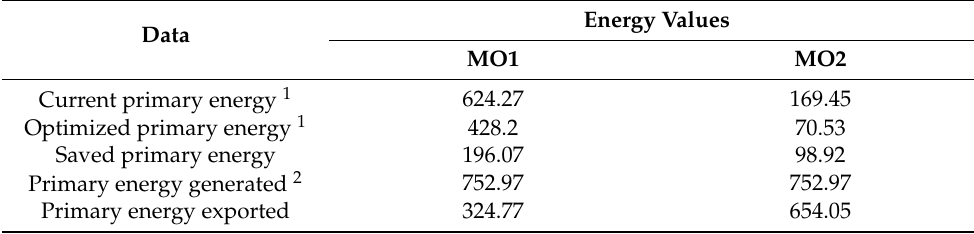
Table 12. Primary energy values obtain in both models.